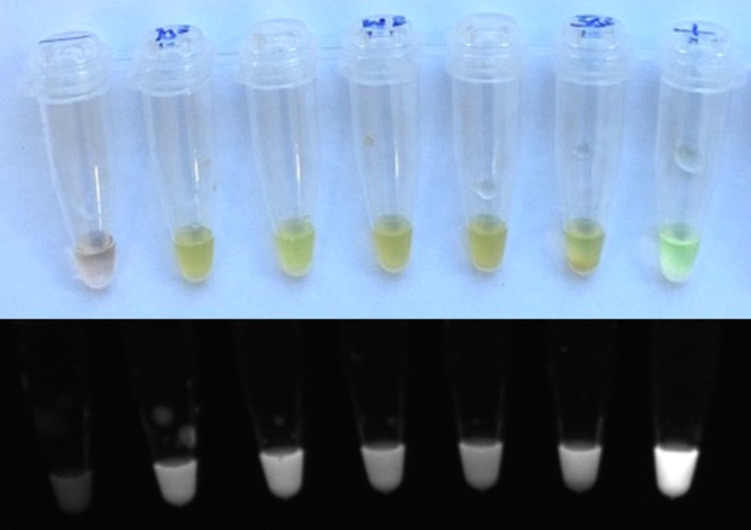
LAMP test result at range of PCVs at a concentration of 1000 parasites/ml in processed blood template.From left to right; negative control, 10% (+), 20%(+), 30% (+), 40% (+), 50% (+), positive control. Fluorescent result is visible in all test tubes. A small amount of cellular debris is visible at the bottom of the 50% tube (upper panel). This is confirmed by imaging in a UV transilluminator, where the positive results show fluorescence (lower panel).